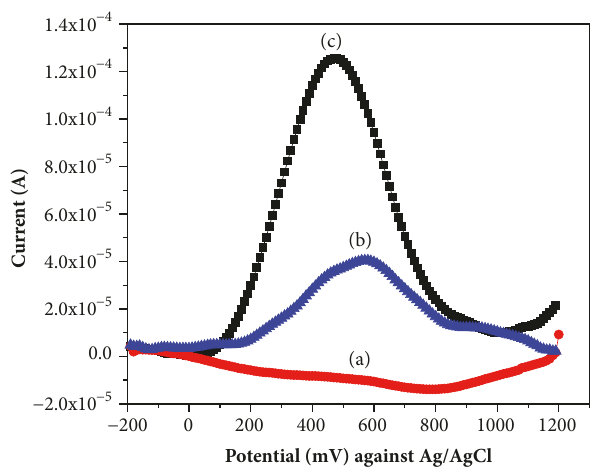
Figure 2: Differentialpulse voltammetry recorded in0.1 MPBS (pH 7) in presence (b and c) and absence (a) of 1 mM uric acid using untreated SPCE (b) and DMF treated SPCE (c) at a scan rate of 10 mV/s, pulse amplitude of 240 mV, and pulse period of 100